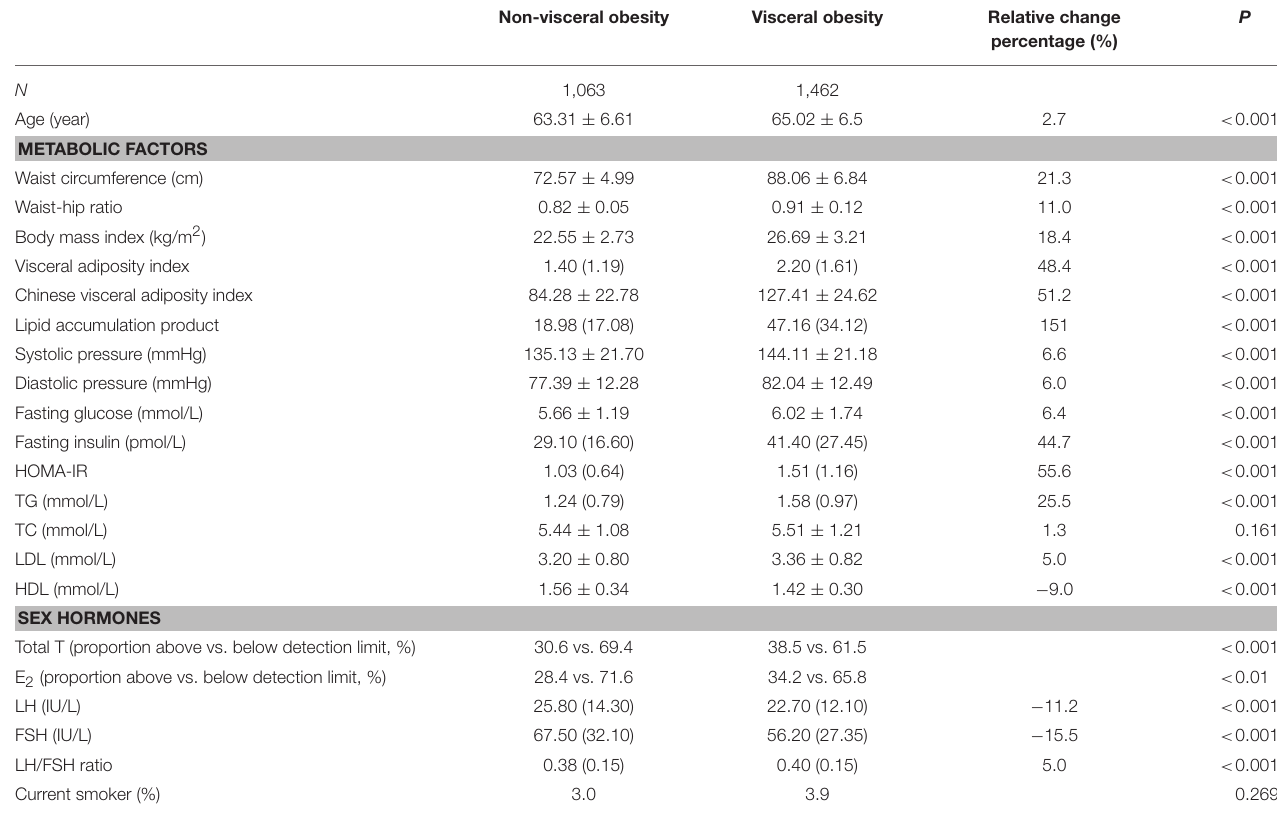
TABLE 1 | General characteristics of the subjects categorized by waist